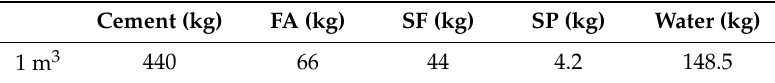
Table 3. Mixture of lightweight concrete (LC) (per m 3